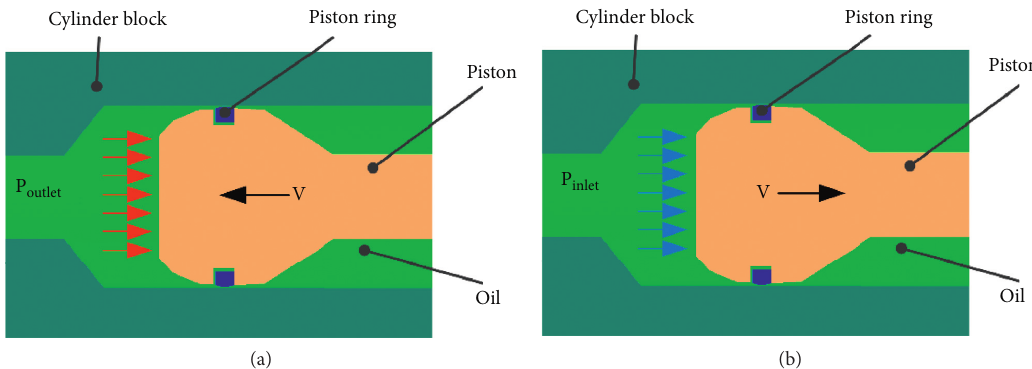
Figure 2: The behavior of PRCB. (a) The discharge region; (b) the suction region.